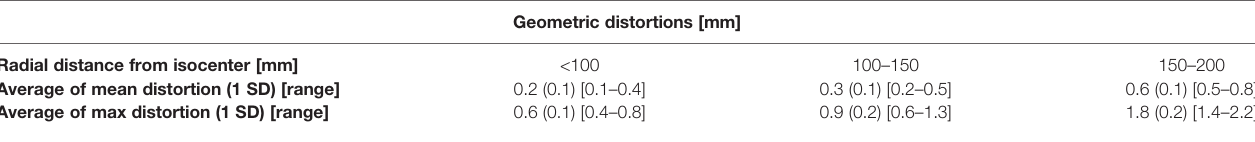
TABLE 3 | Geometric distortion measured using the Spectronic GRADE phantom, presented as the average of the monthly individual mean and maximum distortions for each given radial distance from the MRI scanner isocenter. Geometric distortions [mm] Radial distance from isocenter [mm]